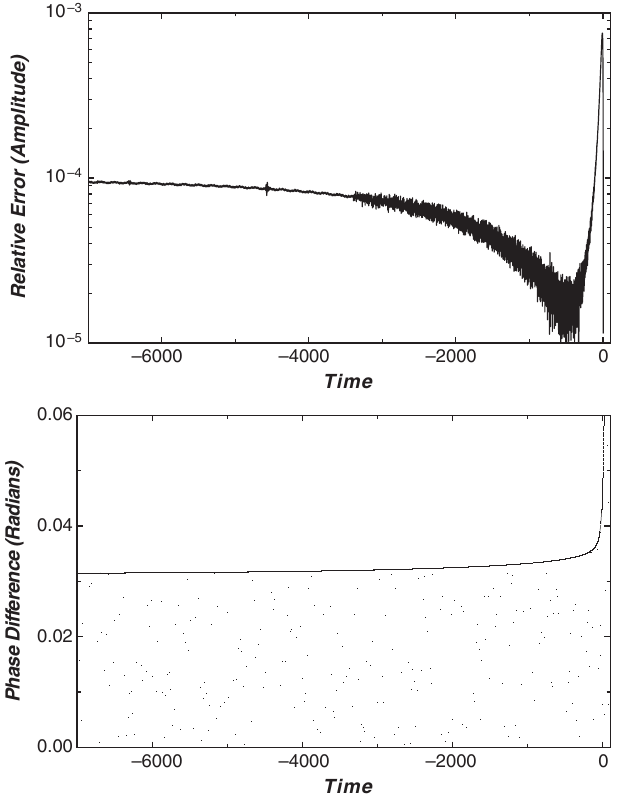
FIG. 3. Relative difference in amplitude (top) and phase dif- ference (bottom) between the hyperboloidal code and the Cauchy code. For clarity, it is worth pointing out that the phase difference reaches a maximum in the ballpark of 0.06 rad near (cid:3) ¼ 0 .